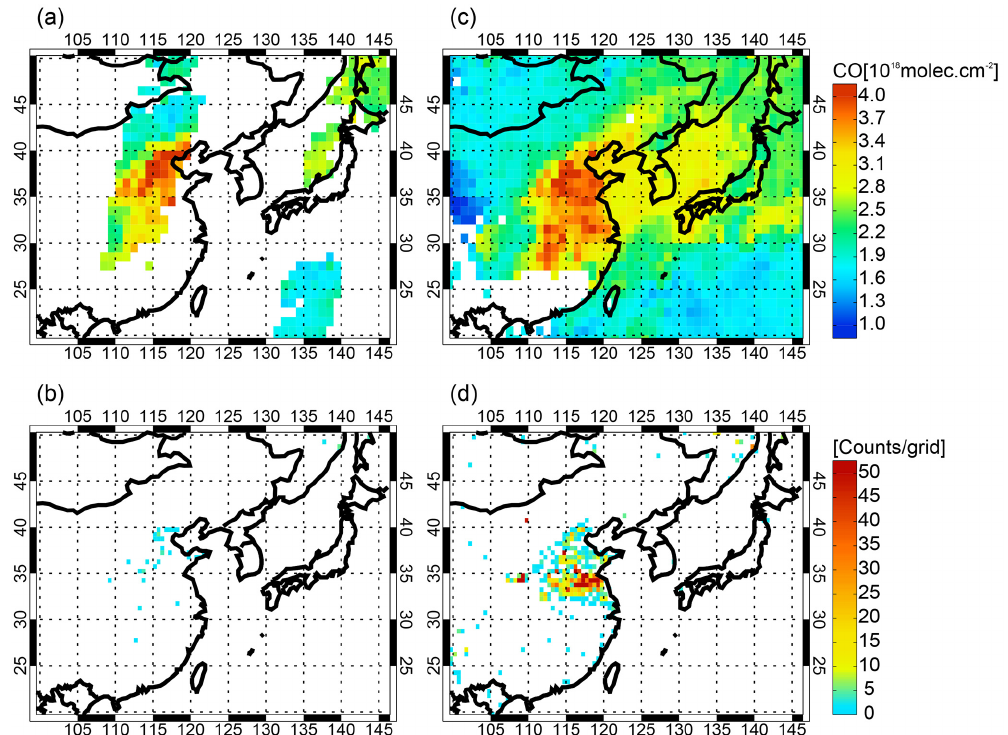
Figure 12. Maps of (a) CO in column number density observed by MOPITT and (b) hotspot numbers taken from MODIS on 22 June 2005 for 0.5 ◦ × 0.5 ◦ grids in latitude and longitude. (c) As for (a) but for the monthly average of June 2005. (d) As for (b) but for the monthly accumulation in June